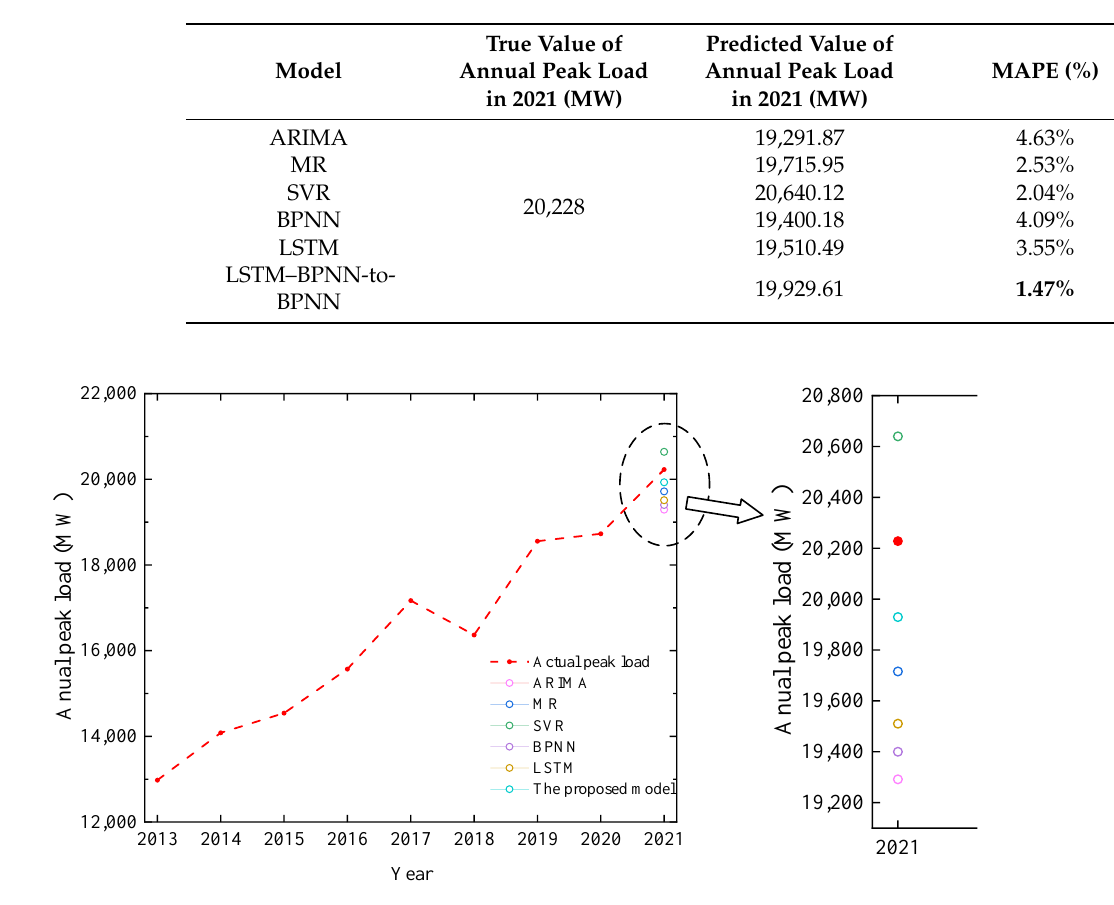
Table 8. Comparison of predictive performance of six models in the forecasting annual peak load in 2021.